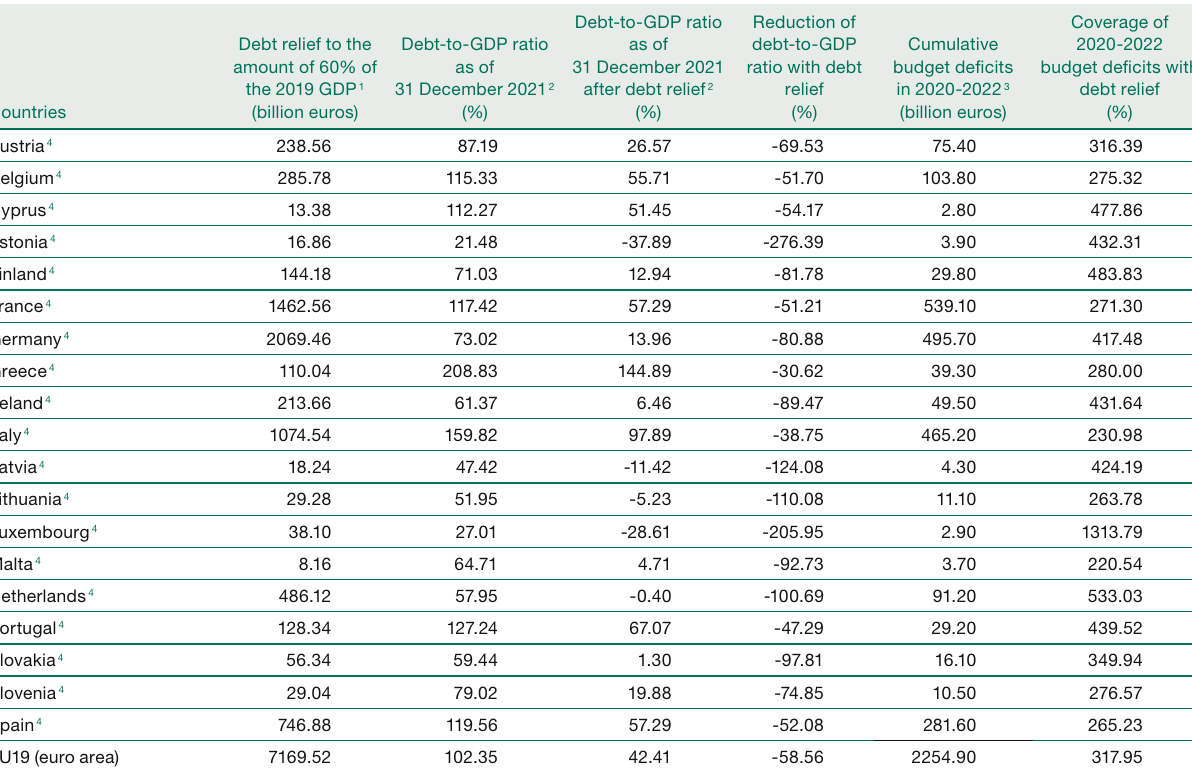
Effects of debt relief of 60% of the 2019 GDP (forecasts as of 12 May